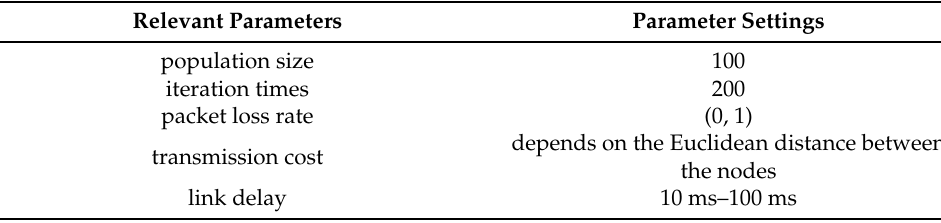
Table 2. Public experimental parameter settings.